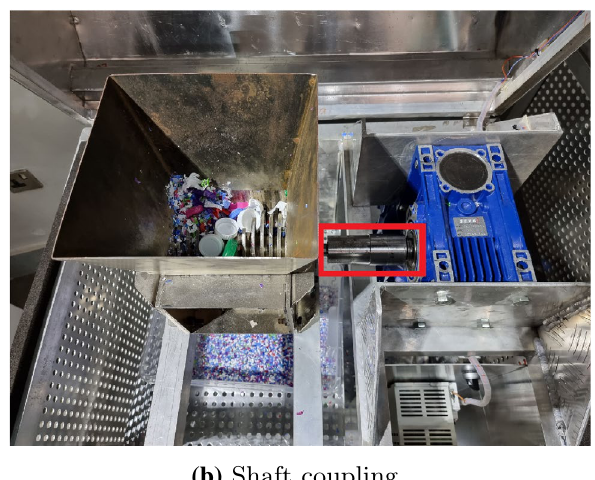
Fig. 7 Sieve and shaft coupling